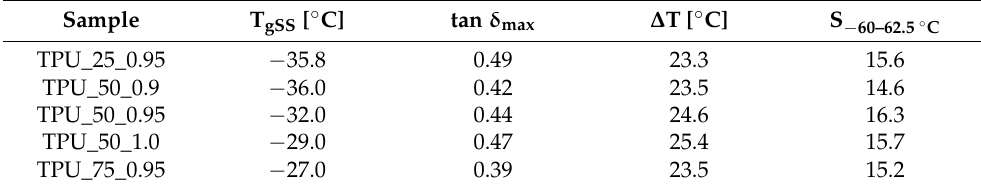
Table 4. DMA results of the prepared green